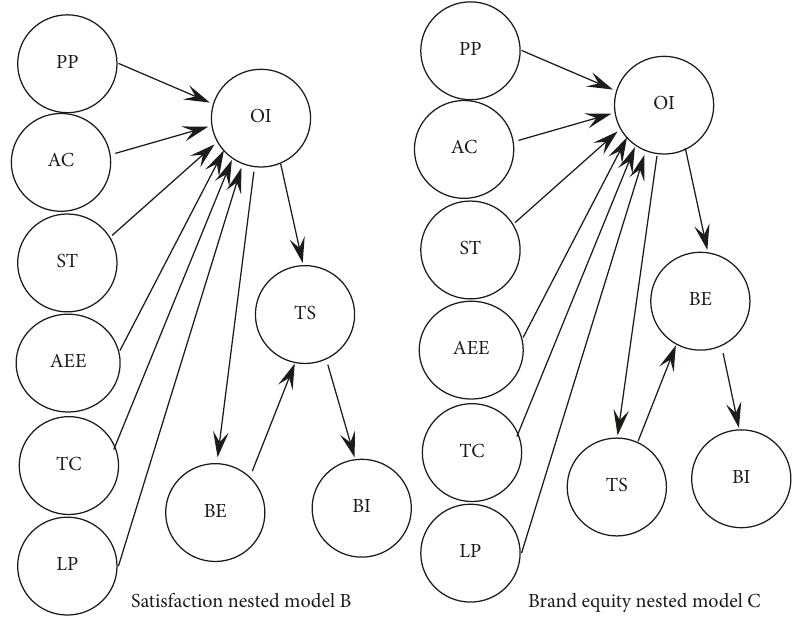
Figure 2: Full mediating model (competitive nested model). Table 3: Setting model verification indicators and relationship hypothesis test